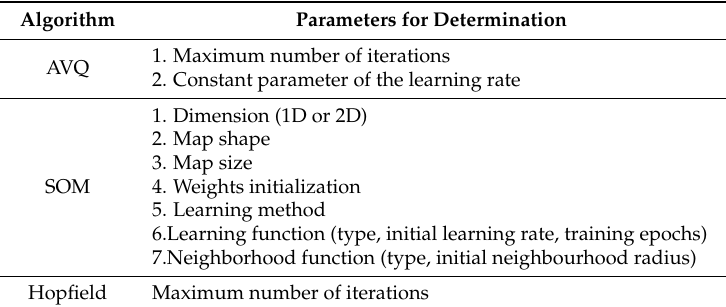
Table 5. Parameters of the neural network-based